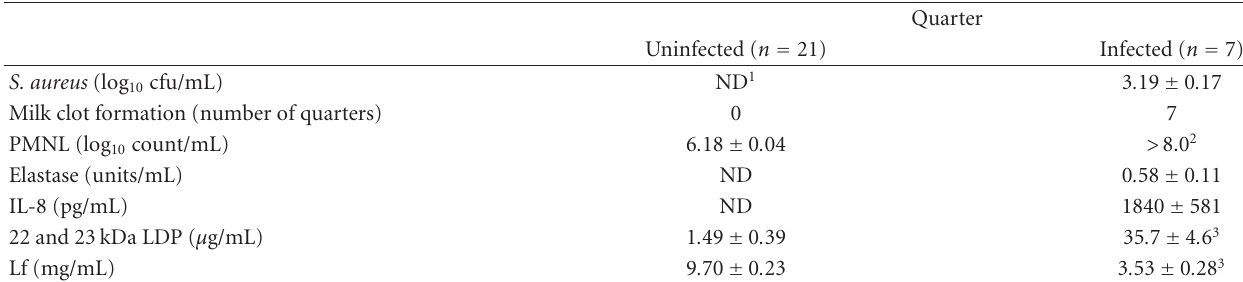
Figure 2: Changes in the IL-8 concentrations of the mammary secretions produced by the glands infused with 50 μ g (a) or 10 μ g (b) of rbIL-8 during the drying-o ff period. Table 1: Milk clot formation; PMNL count; elastase activity; concentrations of IL-8, 22 and 23kDa LDP, and Lf in mammary secretions from the uninfected and infected quarters of cows with S. aureus dry-period